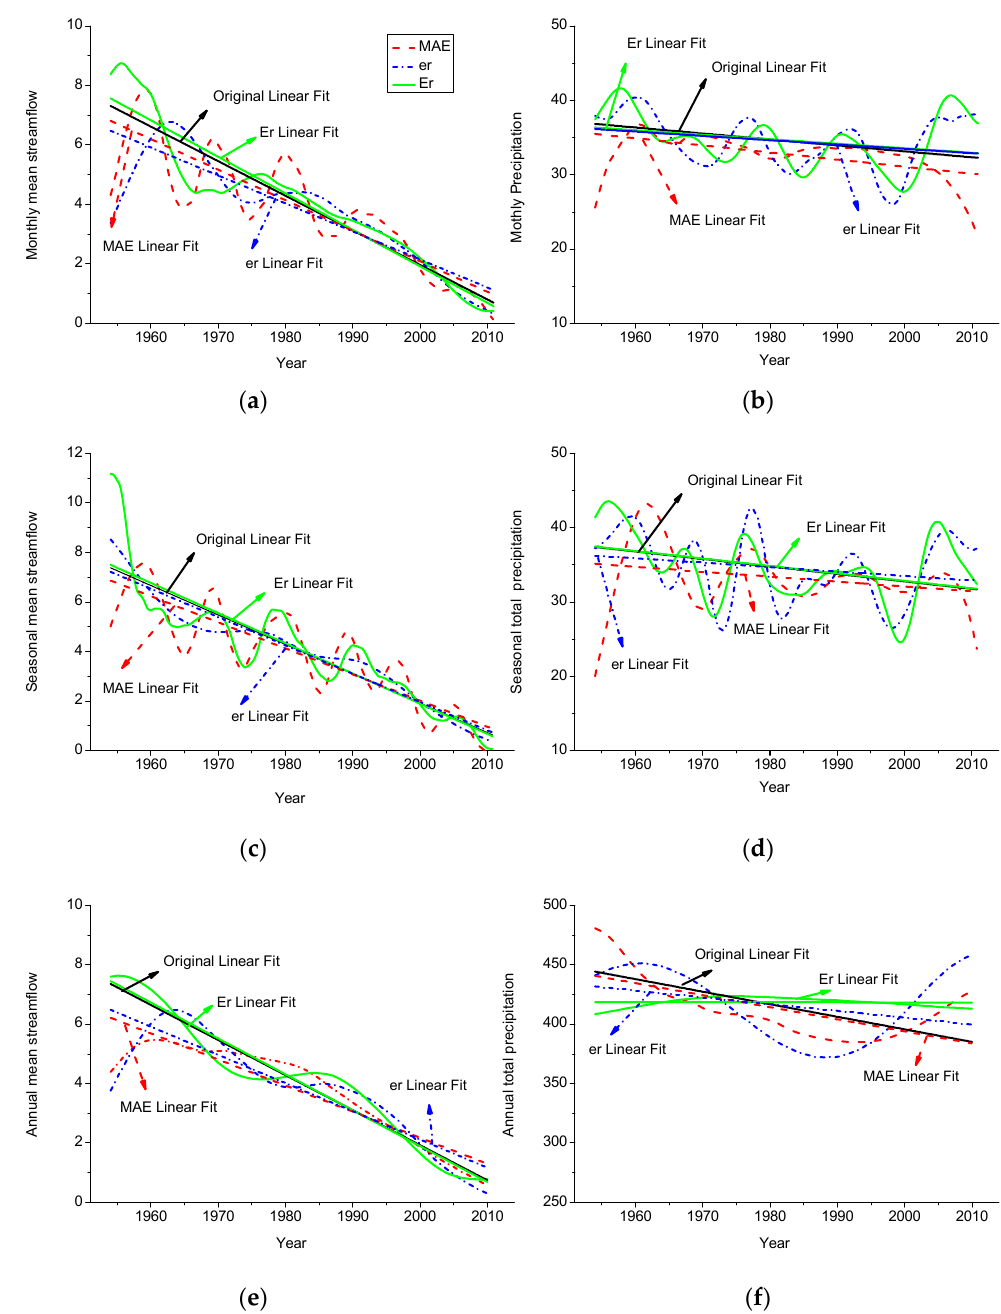
Figure 6. Linear fit of original series and approximate components of monthly, seasonal and annual streamflow and precipitation series in the three criteria. ( a ) monthly streamflow; ( b ) monthly precipitation; ( c ) seasonal streamflow; ( d ) seasonal precipitation; ( e ) annual streamflow; ( f ) annual precipitation.